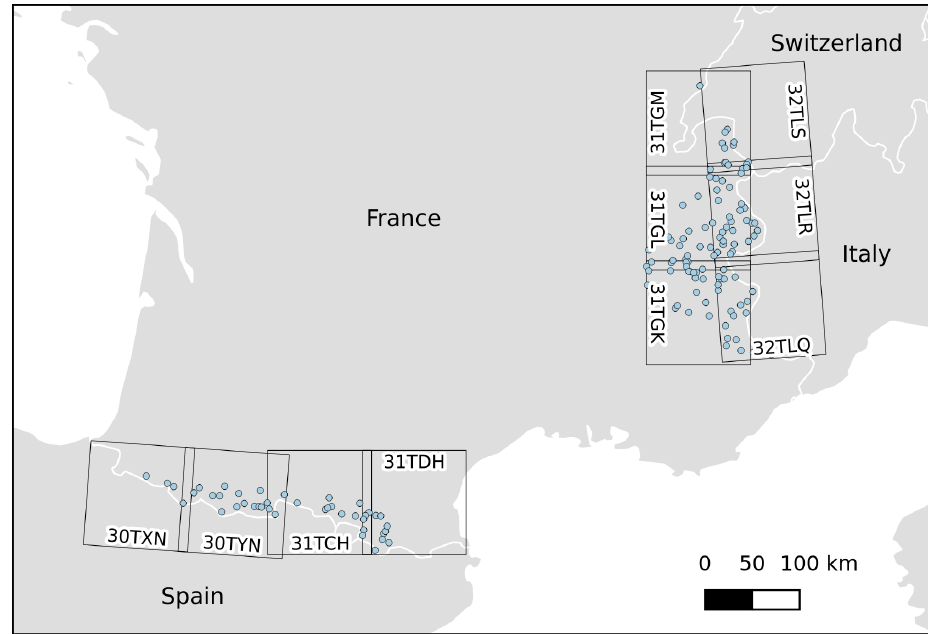
Figure 8. Map showing the location of the stations in the réseau nivo-météorologique (Météo-France snow observation network) used for this study (source: Météo-France) and the corresponding Sentinel-2 tiles.